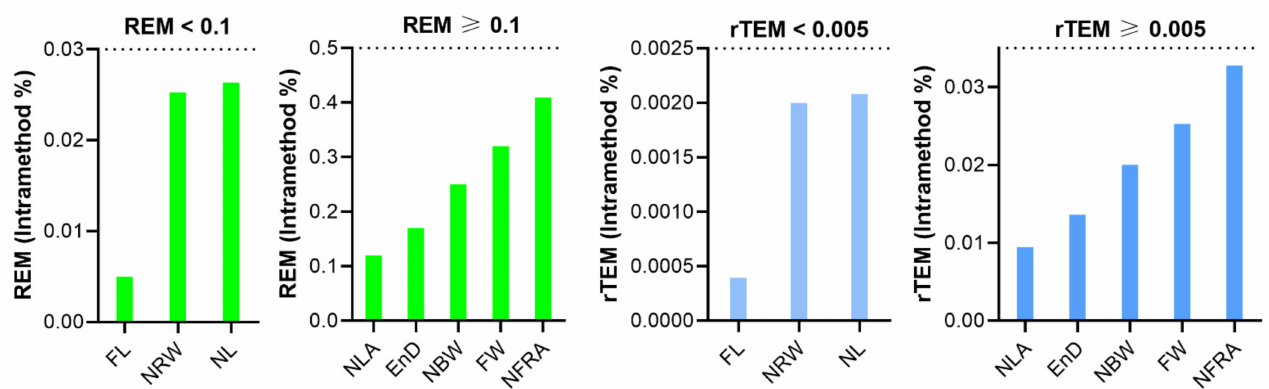
Figure 9. Intra-method relative error measurement (REM) and relative technical error of measurement (rTEM) of classic nasal measurements on three-dimensional images.